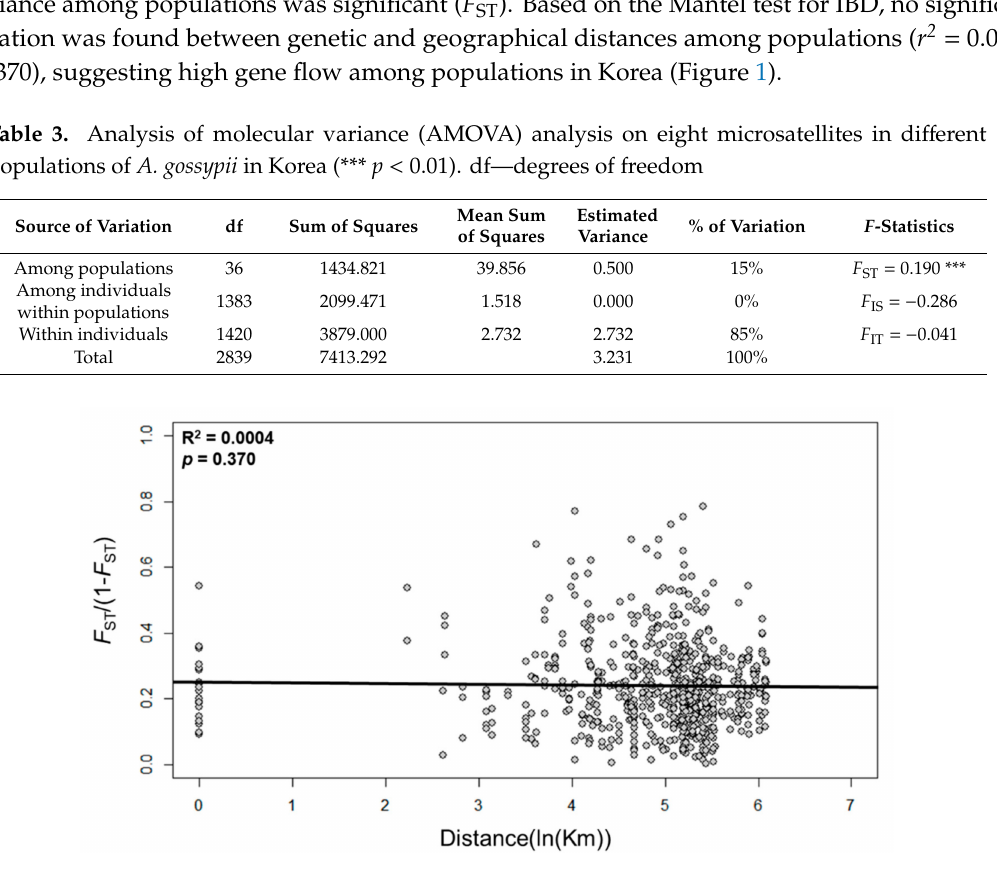
Figure 1. Geographical distance versus genetic distance ( F ST / 1 − F ST ) for populations of Aphis gossypii , using pairwise F ST . Correlations and probabilities were estimated from a Mantel test with 9999 bootstrap